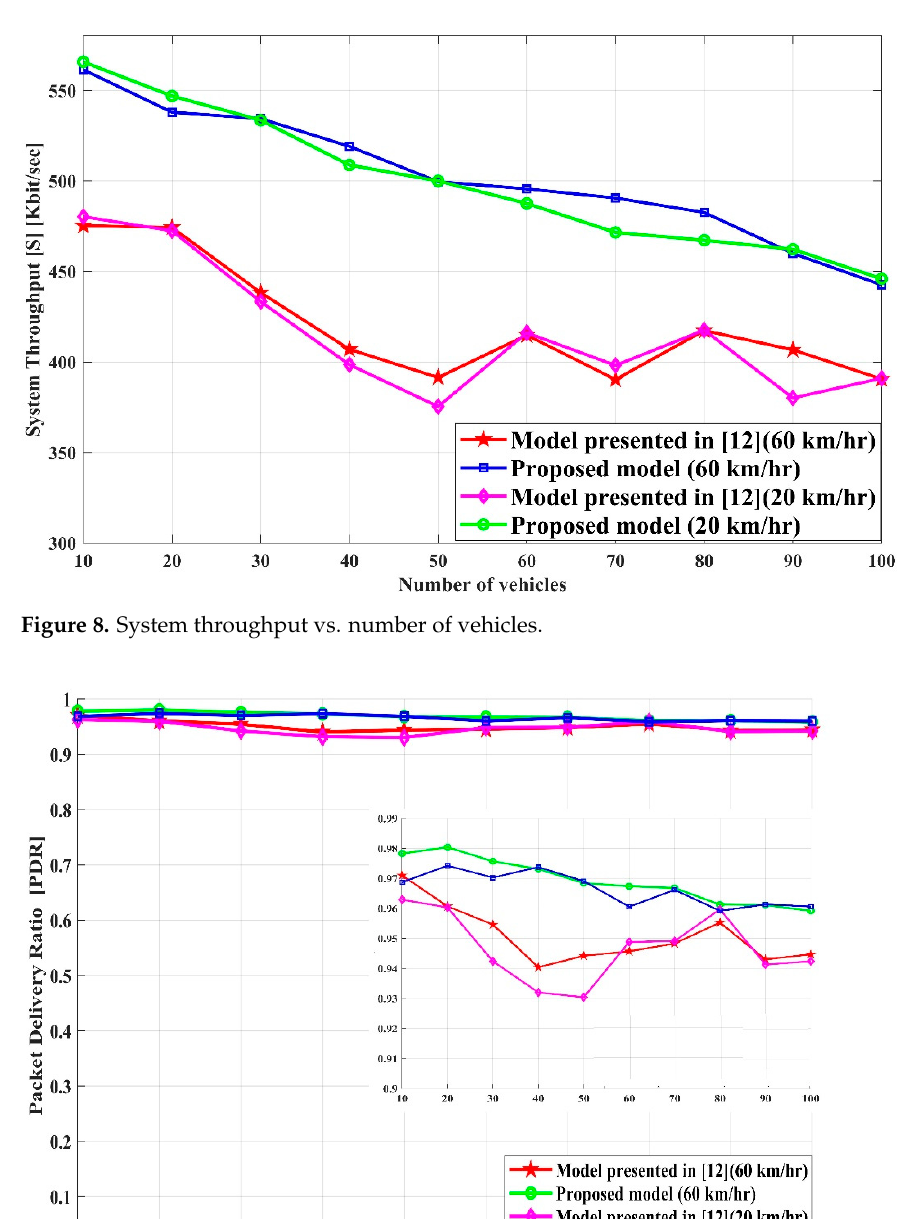
Figure 9. Packet delivery ratio (PDR) vs. number of vehicles.